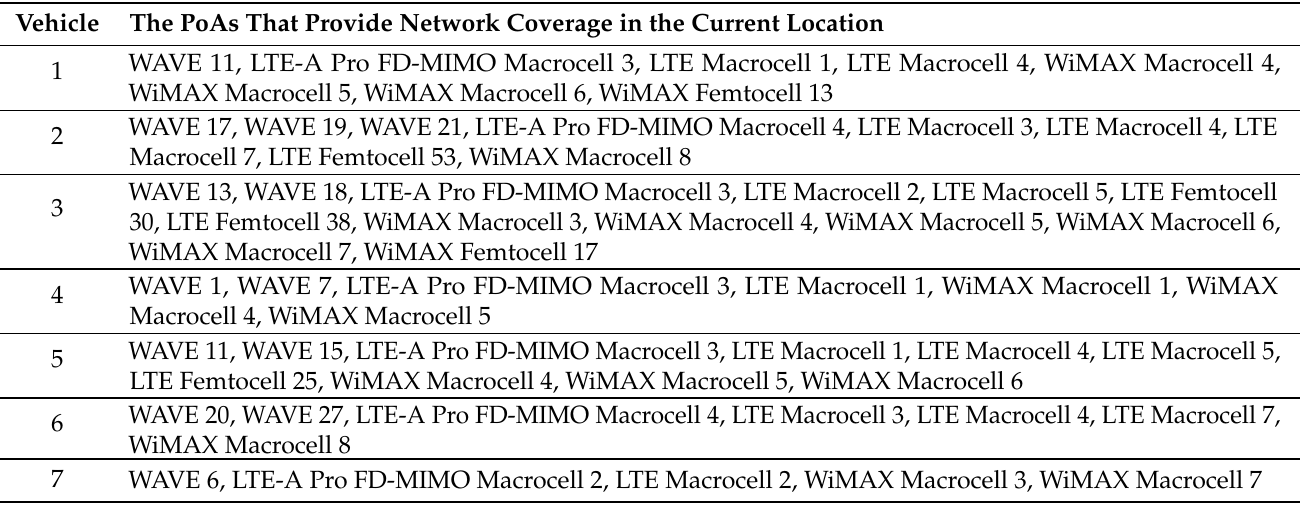
Table 3. The networks that are available in the area of each monitored